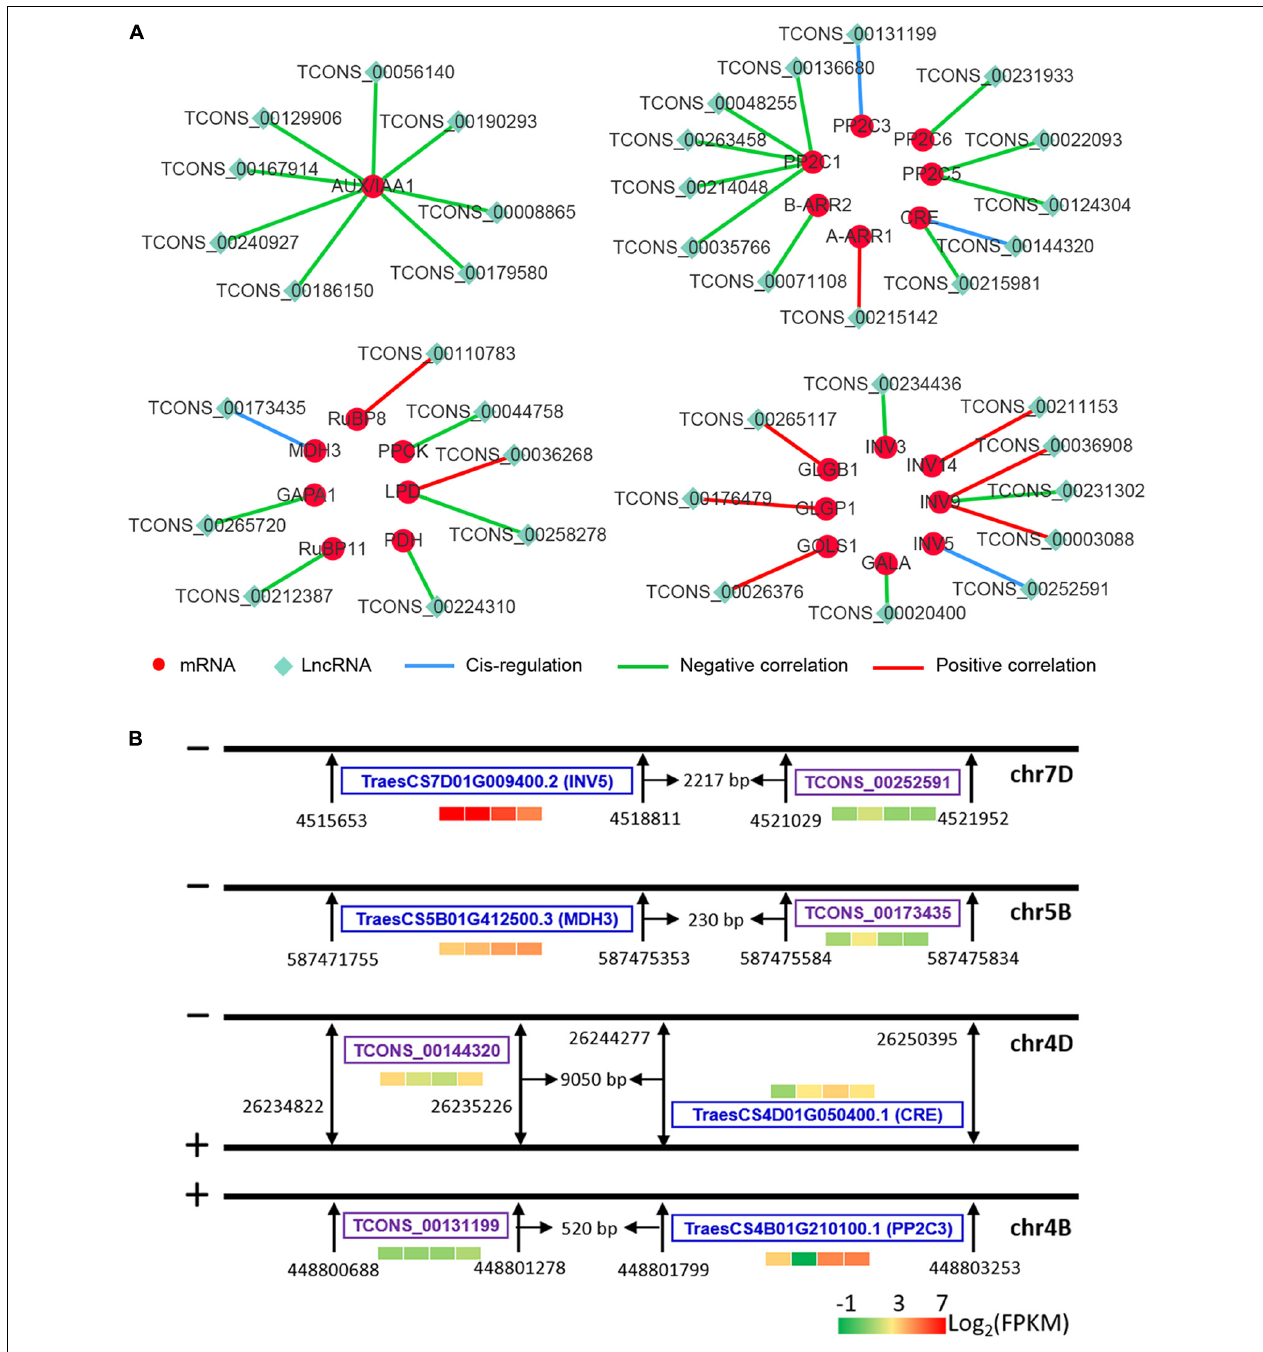
FIGURE 10 | Interaction between mRNAs and lncRNAs. Red and green nodes represent mRNAs and lncRNAs, respectively. Blue edges represent the cis-regulation by lncRNAs of their neighboring mRNAs. Green and red edges represent negative and positive correlations between lncRNAs and mRNAs, respectively. PP2C , protein phosphatase 2C; B-ARR , type-B Arabidopsis response regulator; A-ARR , type-A Arabidopsis response regulator; CRE , cytokinin receptor; MDH , malate dehydrogenase; GAPA , glyceraldehyde-3-phosphate dehydrogenase; RuBP , ribulose bisphosphate carboxylase; PPCK , phosphoenolpyruvate carboxykinase; LPD , dihydrolipoyl dehydrogenase; GLGB , 4- α -glucan branching enzyme; GLGP , amylophosphorylase; GALA , α -galactosidase; GOLS , inositol 3- α -galactosyltransferase; INV , β -fructofuranosidase. T0, T1, T2, and T3 means that the sample was harvested at 0, 2, 24, and 72 h after mowing,